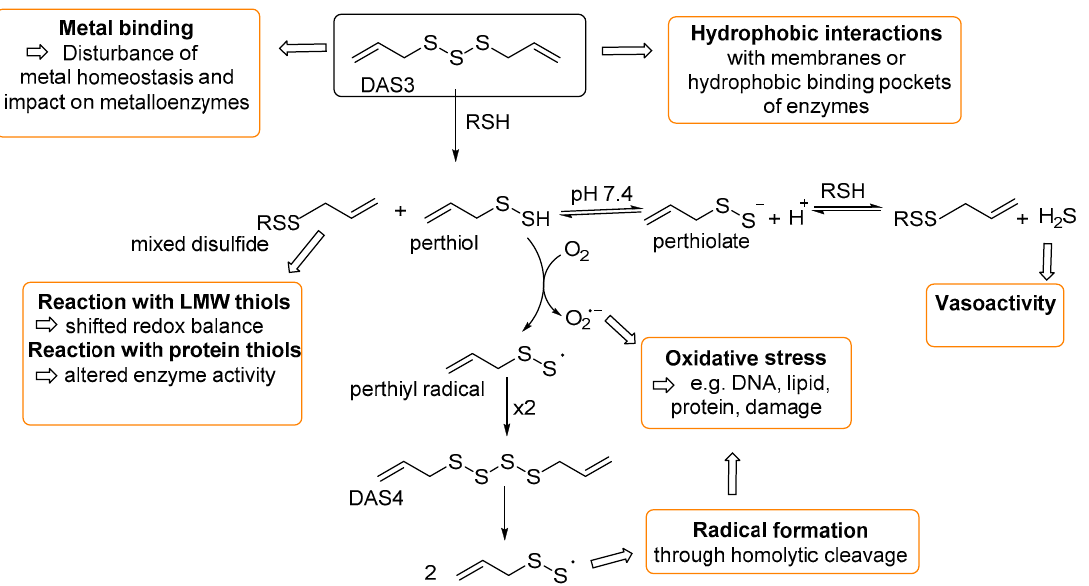
Figure 2. Using DAS3 as an example, possible intracellular reaction pathways of DAPS and their physiological consequences. All reactions described above are possible for DAS3–DAS6, whereas DAS2 is limited to thiol/disulfide reactions with glutathione and protein thiols to form mixed disulfides.